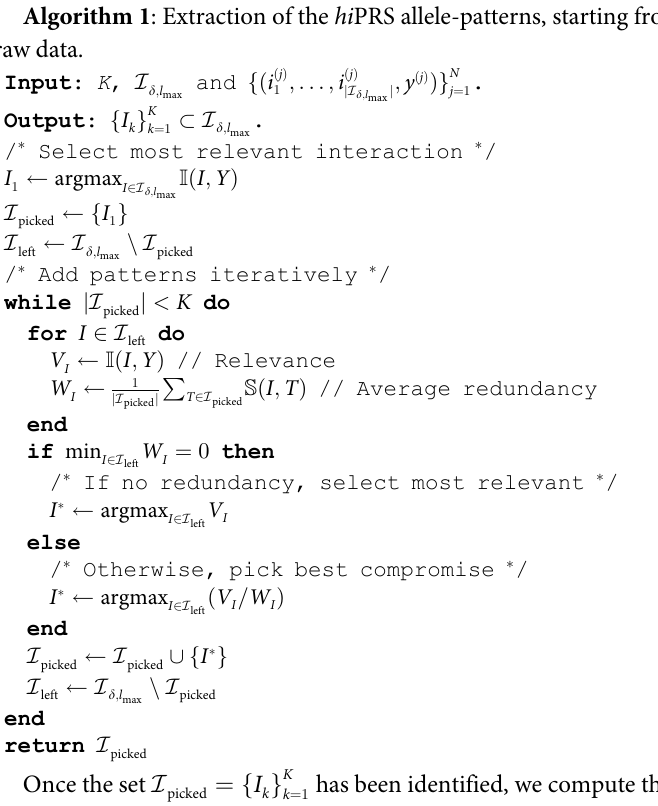
Algorithm 1 : Extraction of the hi PRS allele-patterns, starting from a list of candidates and raw